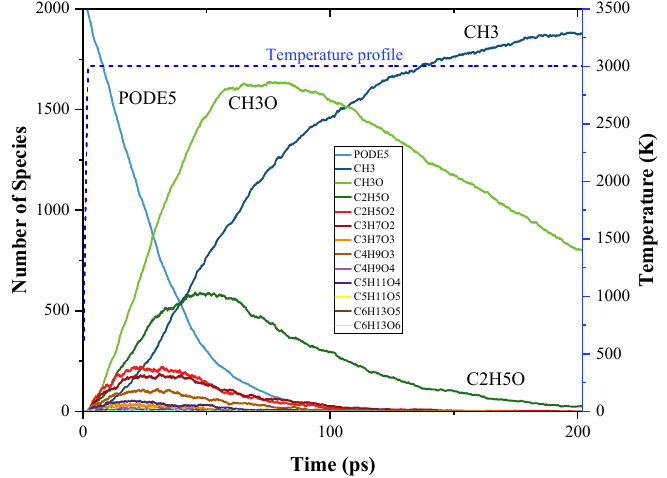
Figure 7. Time evolution of PODE5 and the products from the initial decomposition during the simulation of PODE5 pyrolysis using ReaxFF MD; temperature profile of MD simulation.